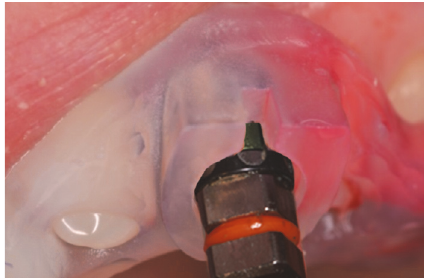
Figure 5: Digital impression of the implants after screwing the scan